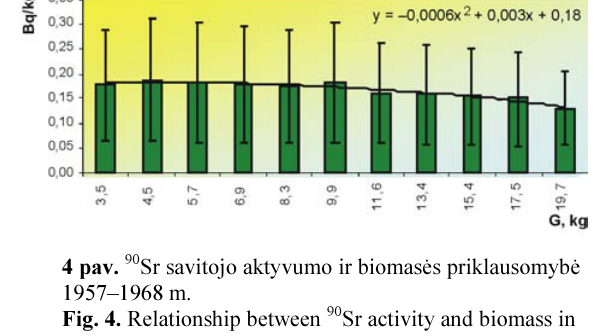
Fig. 4. Relationship between